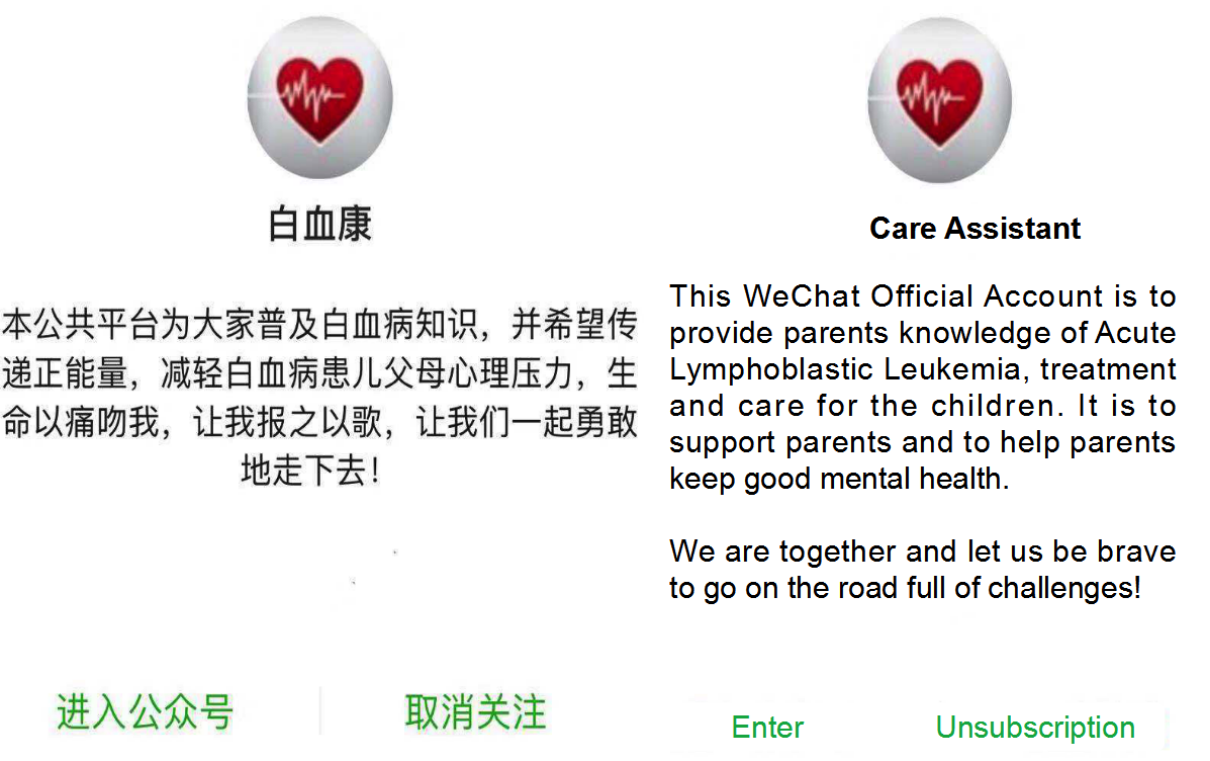
Figure 1. WeChat Official Account welcome